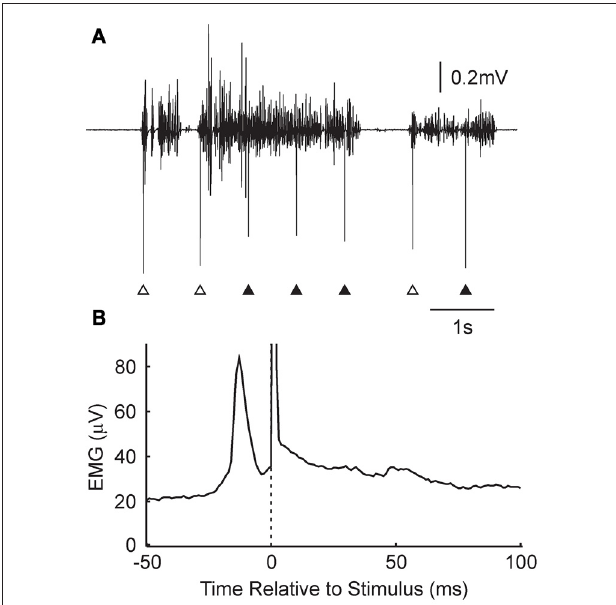
FIGURE 4 | Details of stimulus timing in the Activity condition. (A) Example EMG recording from the wearable device, and associated stimulus times (arrowheads). Some stimuli were given just after the onset of a contraction (open arrowheads); others occurred in the middle of a tonic contraction (filled arrowheads). (B) Stimulus triggered average of rectified EMG, for the subject shown in (A). A narrow peak in activity is visible just prior to the stimulus (time zero, marked by dotted line and stimulus artifact). N = 11,024